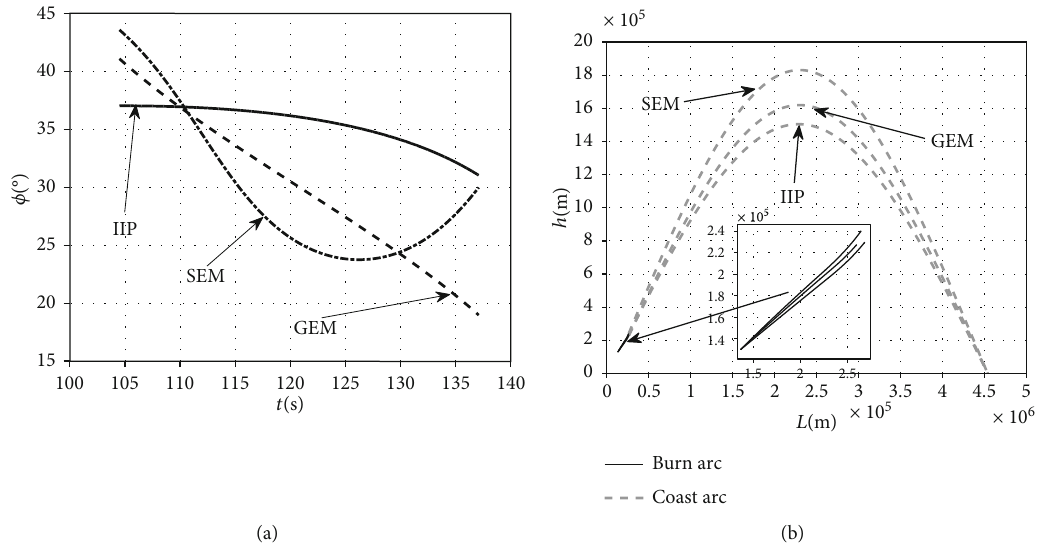
Figure 6: Pro fi les of the state parameters compared IIP and GEM with the SEM method. (a) The pitch angle vs. time. (b) The altitude vs. range.